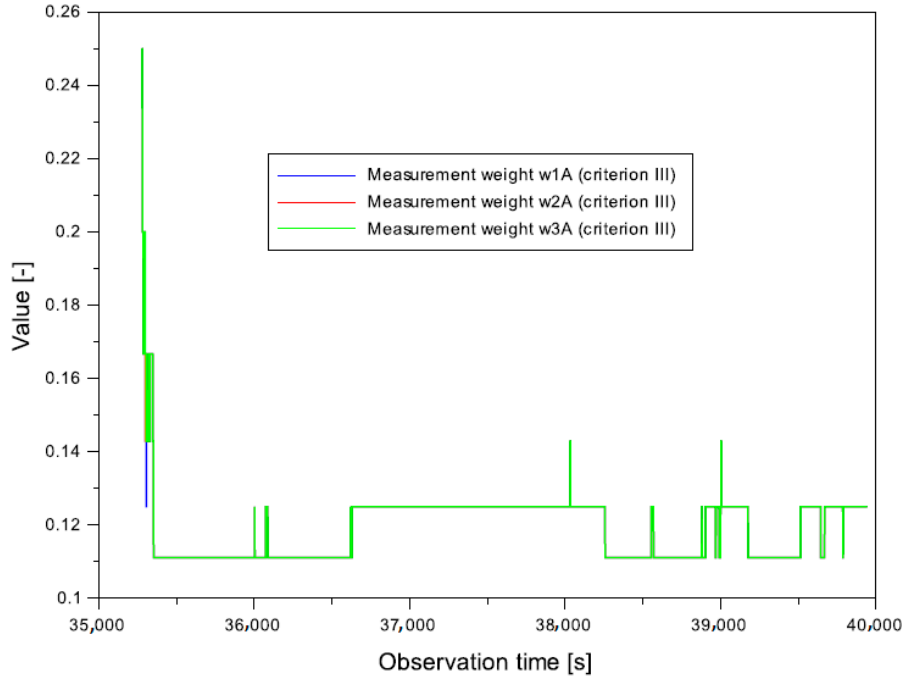
Figure 20. The measurement weights for criterion III.